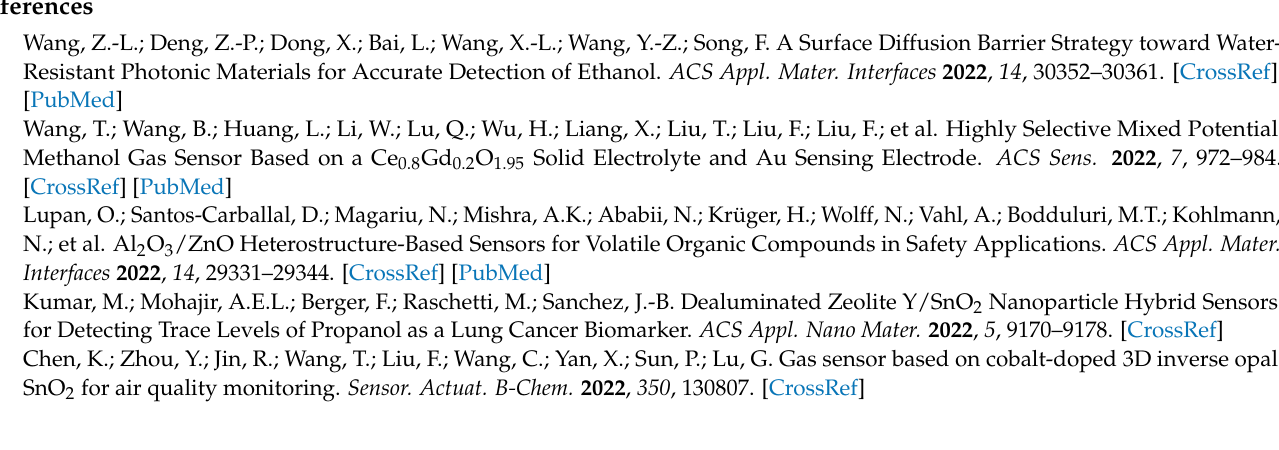
Table S1: Hydrogel formulation optimization